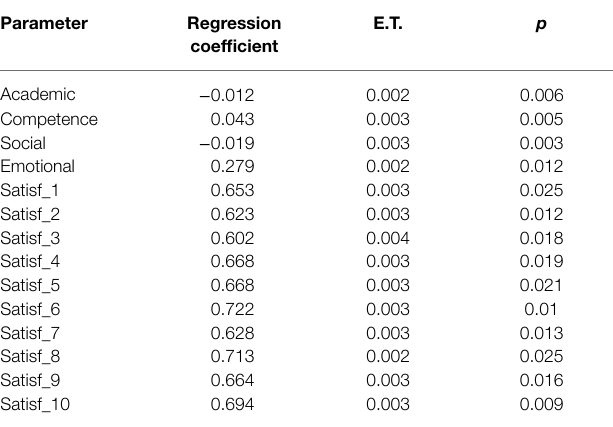
TABLE 10 | Results (regression coefficients and significant effects) for wellbeing construct. Parameter